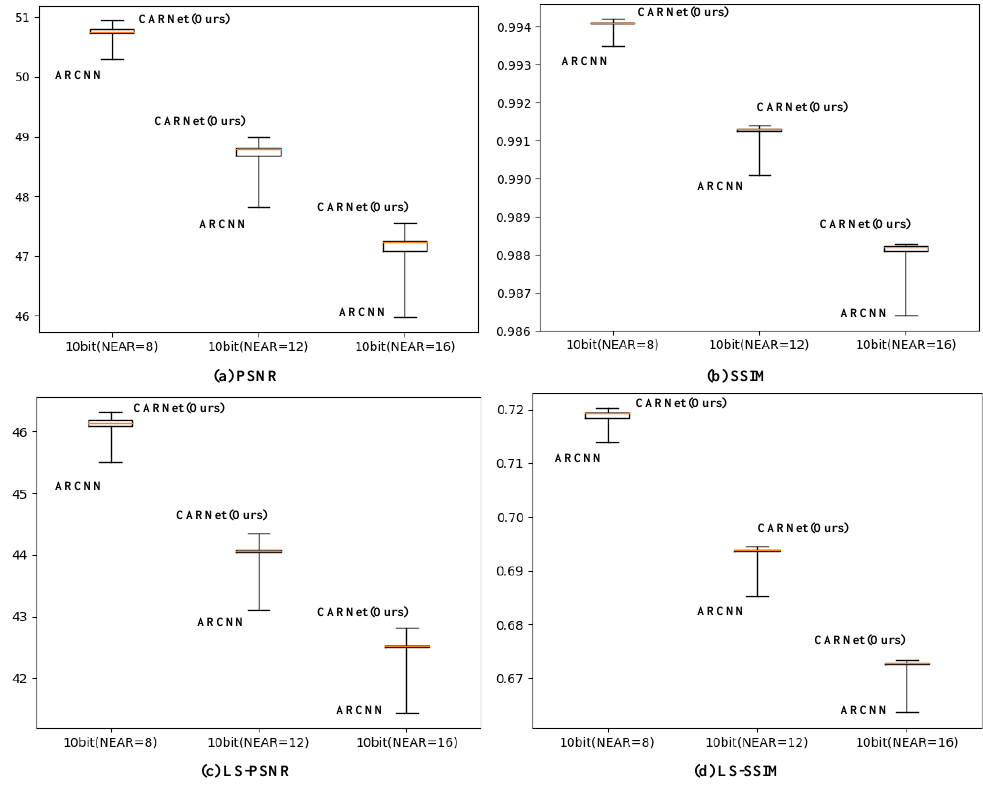
Figure 9. The quantitative results’ distribution of all evaluation indexes on our 10-bit dataset, box plot. In each box, the central orange mark represents the median, while the bottom and top edges of the box indicate the max and min values,